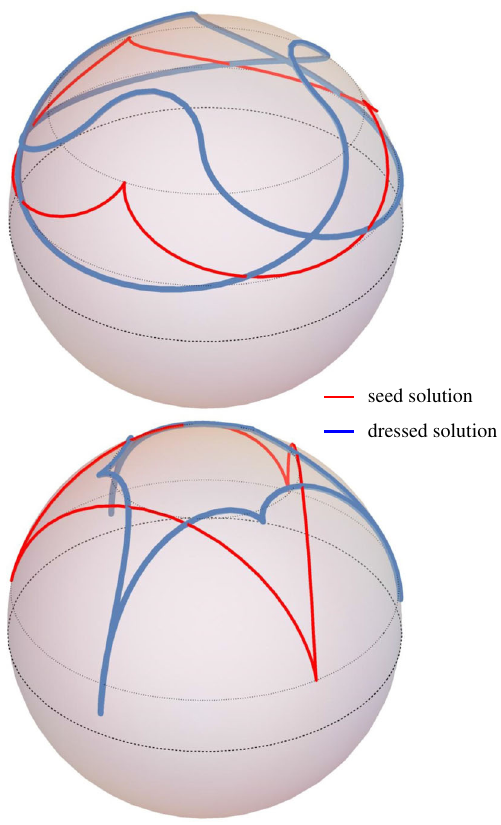
Fig. 18 Two dressed strings with D 2 < 0 with seed solutions, which haveatranslationallyinvariantcounterpart(left)andastaticcounterpart